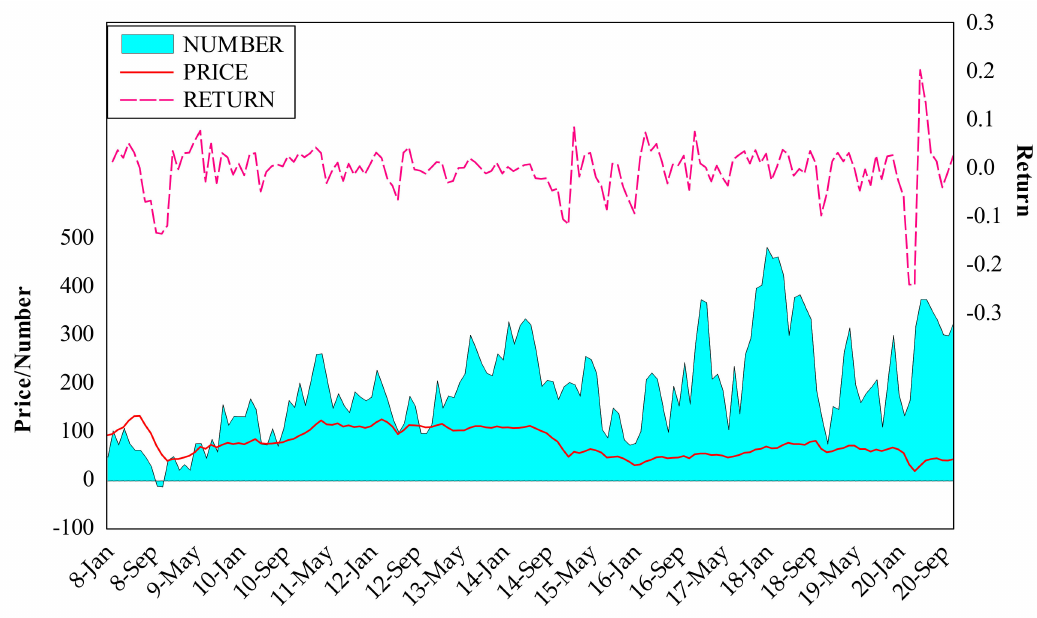
Figure 1. Trading volume of crude oil futures market and crude oil spot price and